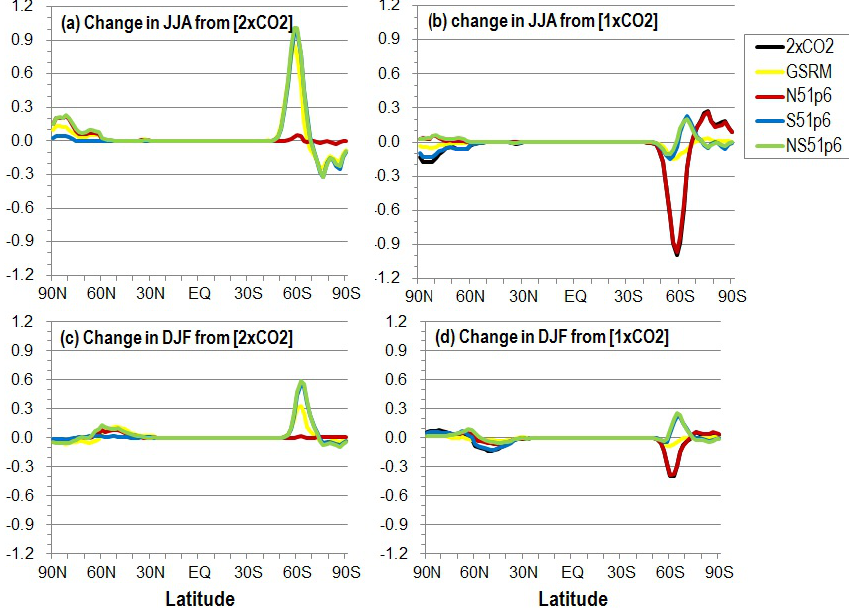
Fig. 8. Latitudinal distribution of the differences in snowfall (in mmday − 1 of precipitation) for June-July-August (JJA – top panels) and December-January-February (DJF – bottom panels) that would result after imposing both a CO 2 doubling and solar reductions of either 1.8% globally or 6% reductions in solar radiation from 51 degrees latitude to the pole in the Northern, Southern, or both Hemispheres. The left column shows the effect of the solar reductions from the 2 × CO 2 simulation and the right column from the 1 × CO 2 baseline. Note expanded scale compared to Fig.